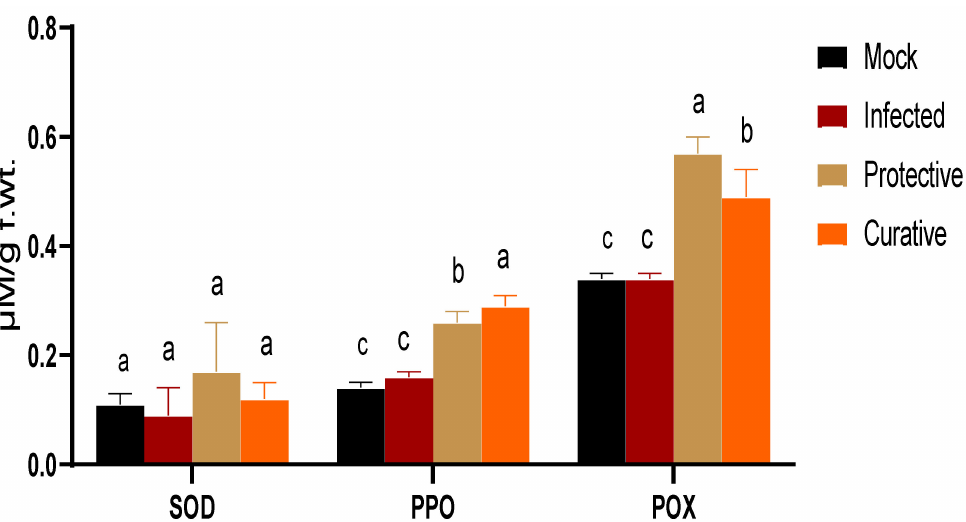
Figure 5. Evaluation of three antioxidant enzymes, including superoxide dismutase (SOD), polyphe- nol oxidase (PPO), and peroxidase (POX) in squash plants. Mock: squash plants foliar sprayed with sterile nutrient broth and mocked with viral inoculation buffer; infected: squash plants mechanically inoculated with ZYMV with foliar spraying of sterile nutrient broth; protective: squash plants sprayed with Paenibacillus polymyxa strain SZYM-CF 24 h before ZYMV inoculation; curative: squash plants sprayed with SZYM-CF 24 h after ZYMV inoculation. The mean values of each column with the same letter do not differ